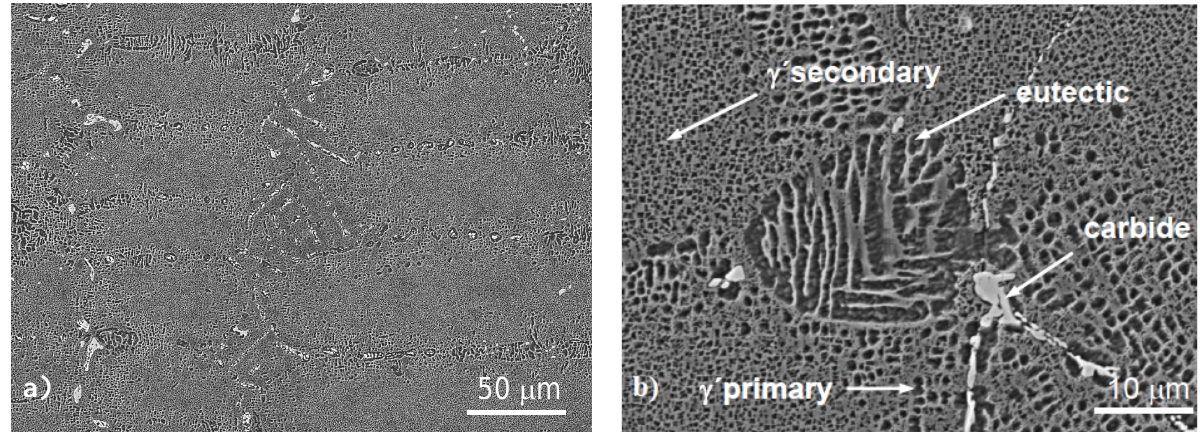
Figure 5: Microstructure of alloy G1 crept at 800 ∘ C and 400MPa at different magnification.